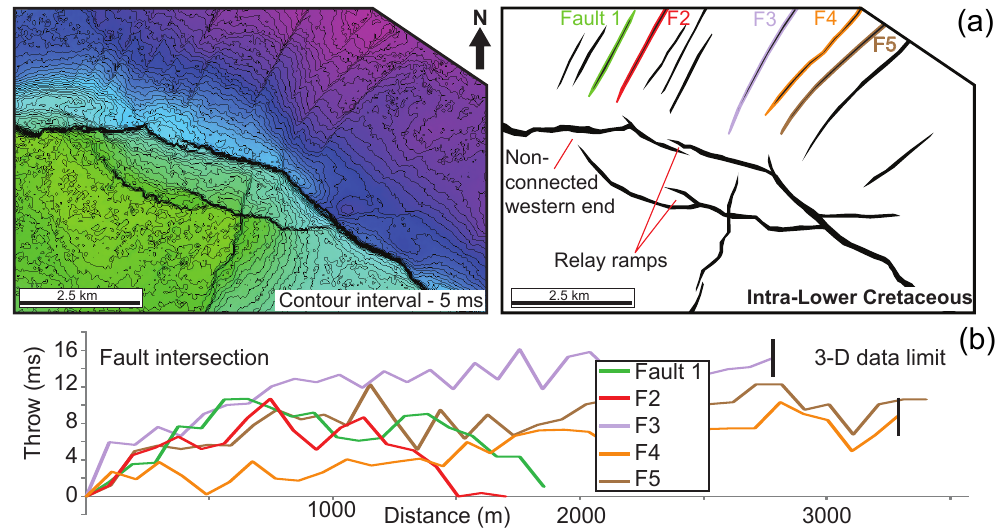
Figure 13. (a) Interpreted and uninterpreted fault geometries of the bend in the Fjerritslev north fault at the ILC stratigraphic horizon. A series of minor, NE-striking faults are present around the outside of the bend, perpendicular to the main fault trace. For the colour bar, see Fig. 12. (b) T-x profiles for the outer-bend faults as calculated for the ILC stratigraphic horizons. Throw maxima are observed outboard of the main Fjerritslev north fault